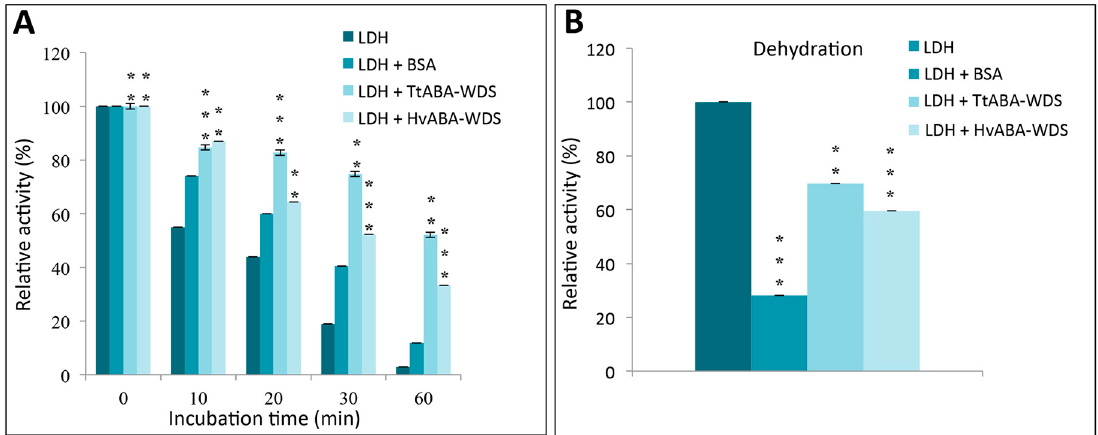
Figure 9. HvABA-WDS and TtABA-WDS domains protect LDH activity under heat stress and dehydration. ( A ) LDH was heated at 43 °C for the specified time in the absence or presence of HvABA-WDS and TtABA-WDS purified domains. A small aliquot was taken at each time point, and LDH activity was measured. ( B ) Residual LDH activity after dehydration and rehydration in the presence or absence of BSA, HvABA-WDS or TtABA-WDS. Data are presented as relative activity (%) with respect to the LDH activity recorded before stress treatment. The values are the mean ± SD from three independent samples. The asterisks denote statistically significant differences (** p < 0.01, *** p < 0.001) as evaluated with Student’s T test.